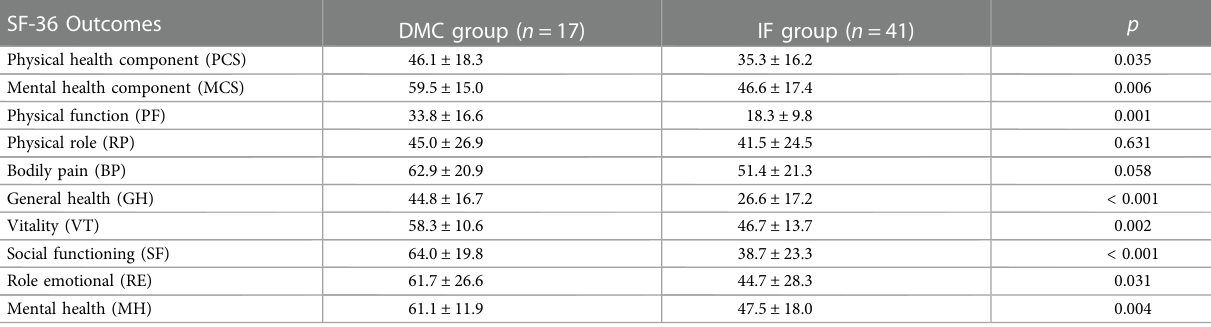
TABLE 3 Subdimension scores of SF-36. Values are shown as